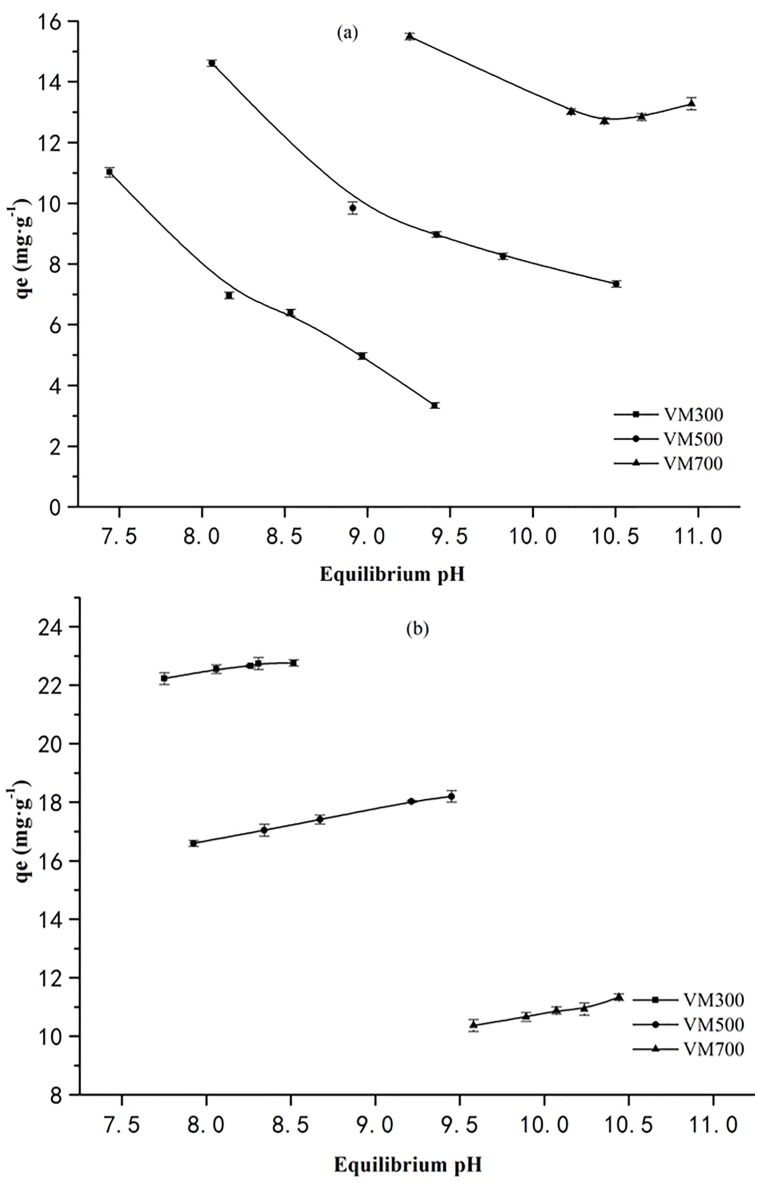
Relationships of equilibrium pH and the adsorption of CR (a) and MB (b) by biochars.